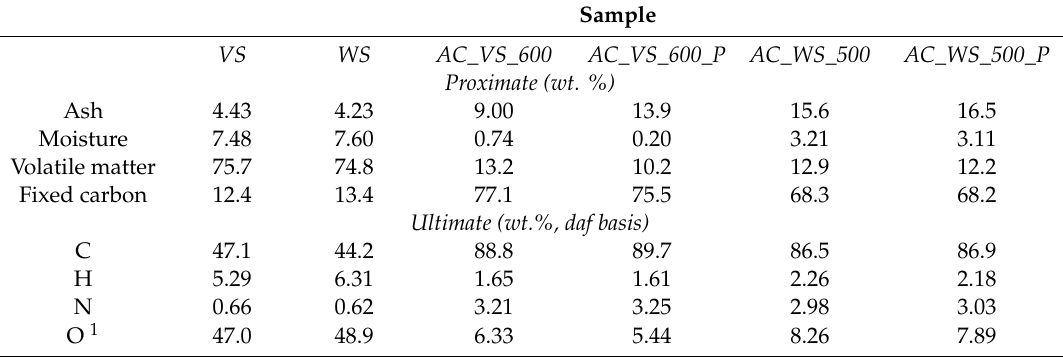
Table 2. Proximate and ultimate analyses of biomass sources (vine shoots (VS) and wheat straw pellets (WS)) and activated